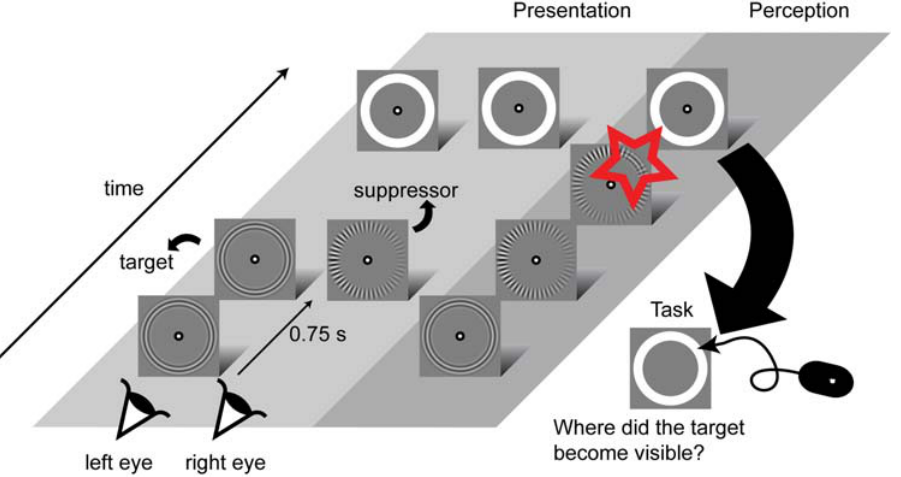
Figure 2. General procedure. In short, one image was flash-suppressed (the target, shown in the most left stream of events) by another image (the suppressor, shown in the middle stream of events). When the suppressor appeared, the target became invisible (most right stream of events). An observer then waited until the target became visible again upon which he or she was instructed to click a mouse button at the location where the target reentered perception. were due to spatial locations per se, and not to variations in stimulus parameters. The background luminance of the monitor was 25.2 cd m-2 for Experiments 1 & 2, and , 0.1 cd m-2 for Experiment 3. Stimuli: Experiment 1 (Figure 1 top row). The rival images in the contrast experiment were sine-wave gratings, where the CONST image consisted of a concentric grating with a fixed contrast of 59.4% (Michelson). The VAR image consisted of a radial grating with a contrast varying between 12% and 100% (Michelson). The spatial frequency of both images was fixed at 3 cpd. Stimuli: Experiment 2 (Figure 1 middle row). In the spatial frequency experiment, the CONST image was a concentric grating with a fixed spatial frequency of 3.9 cpd. The VAR image was a radial grating with a spatial frequency varying between 0.9 and 6.9 cpd. Michelson contrast of each of the images was fixed at 59.4%. Stimuli: Experiment 3 (Figure 1 bottom row). The CONST motion image consisted of dots moving inward or outward at a fixed speed of 3.3 deg s-1. The VAR motion image consisted of dots moving inward or outward at a speed that varied between 0.5 and 6.0 deg s-1. The speed of the individual dots was varied by varying the step size of the individual dots. Dots in both images had a lifetime of 40 frames. On average, each image contained 400 dots per frame. At each trial, dots in one of the images were green and dots in the other red. Also, one of the images contained inward and the other one outward motion (presentation of these features was counterbalanced). The green and red dots were presented at the observers’ perceptual isoluminance, which was acquired by using a flicker-matching procedure (by matching red to green (green: luminance 14.6 cd m- 2, x= .292, y = .607)).